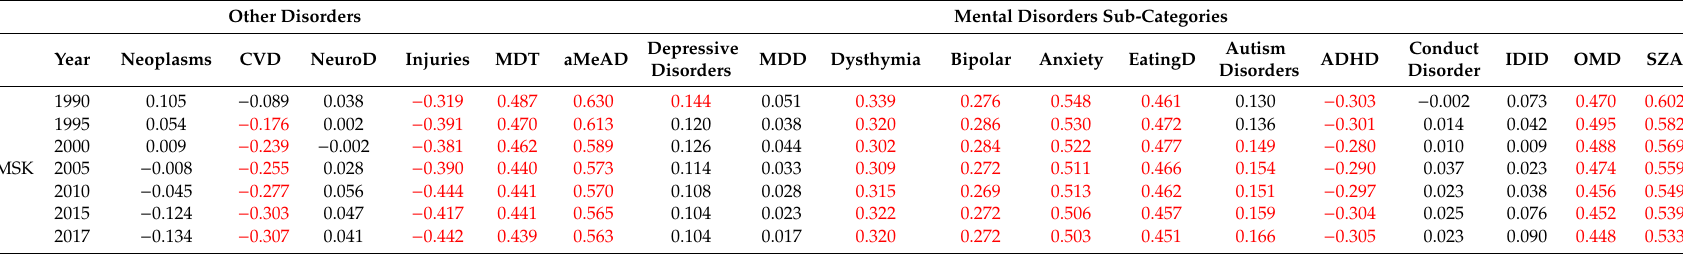
Table 2. Spearman’s correlation coe ffi cients between age-standardized DALYs attributed to musculoskeletal disorders and age-standardized DALYs attributed to various disorders, among 195 countries, in both sexes, for 1990 to 2017.